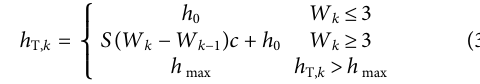
FIGURE 6 Schematic diagram of the triangular